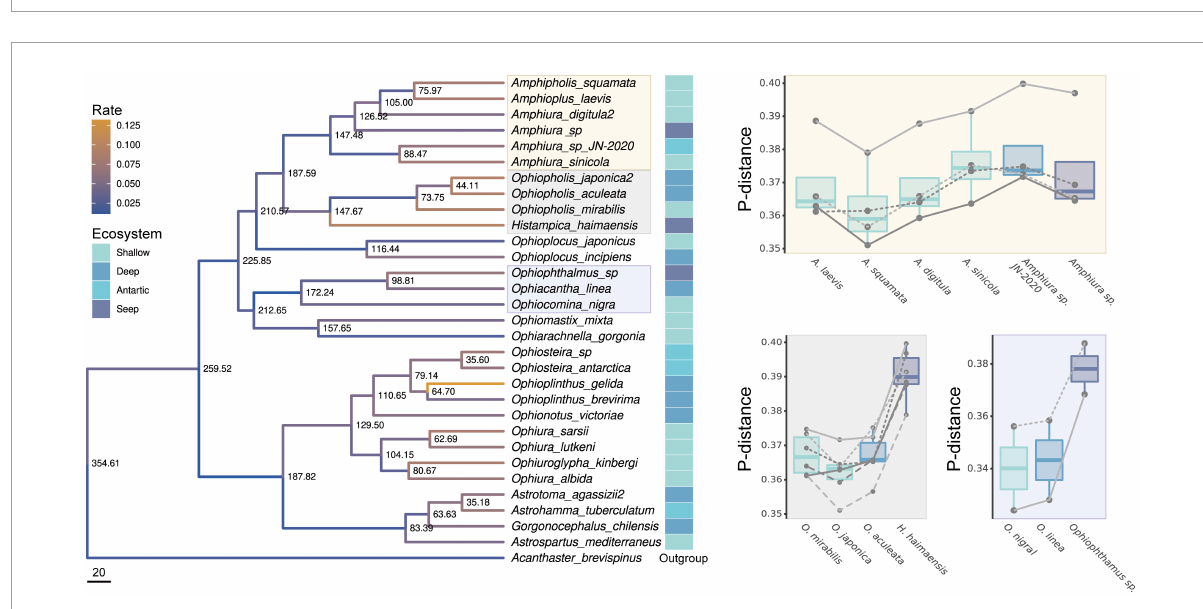
FIGURE3 Reconstructed phylogenetic relationship of brittle star mitogenome. Node labels show the dating time of the BEAST2 analysis. Branches were colored by the rate. Three clades consist of shallow, deep-sea and cold-seep species were labeled in colored boxes. For each clade, p-distances between in-clade species to its sister-clade species were illustrated on the right panels of corresponding colors as boxes around the species names, with boxes colored by ecosystem; each line represents a sister-clade species.